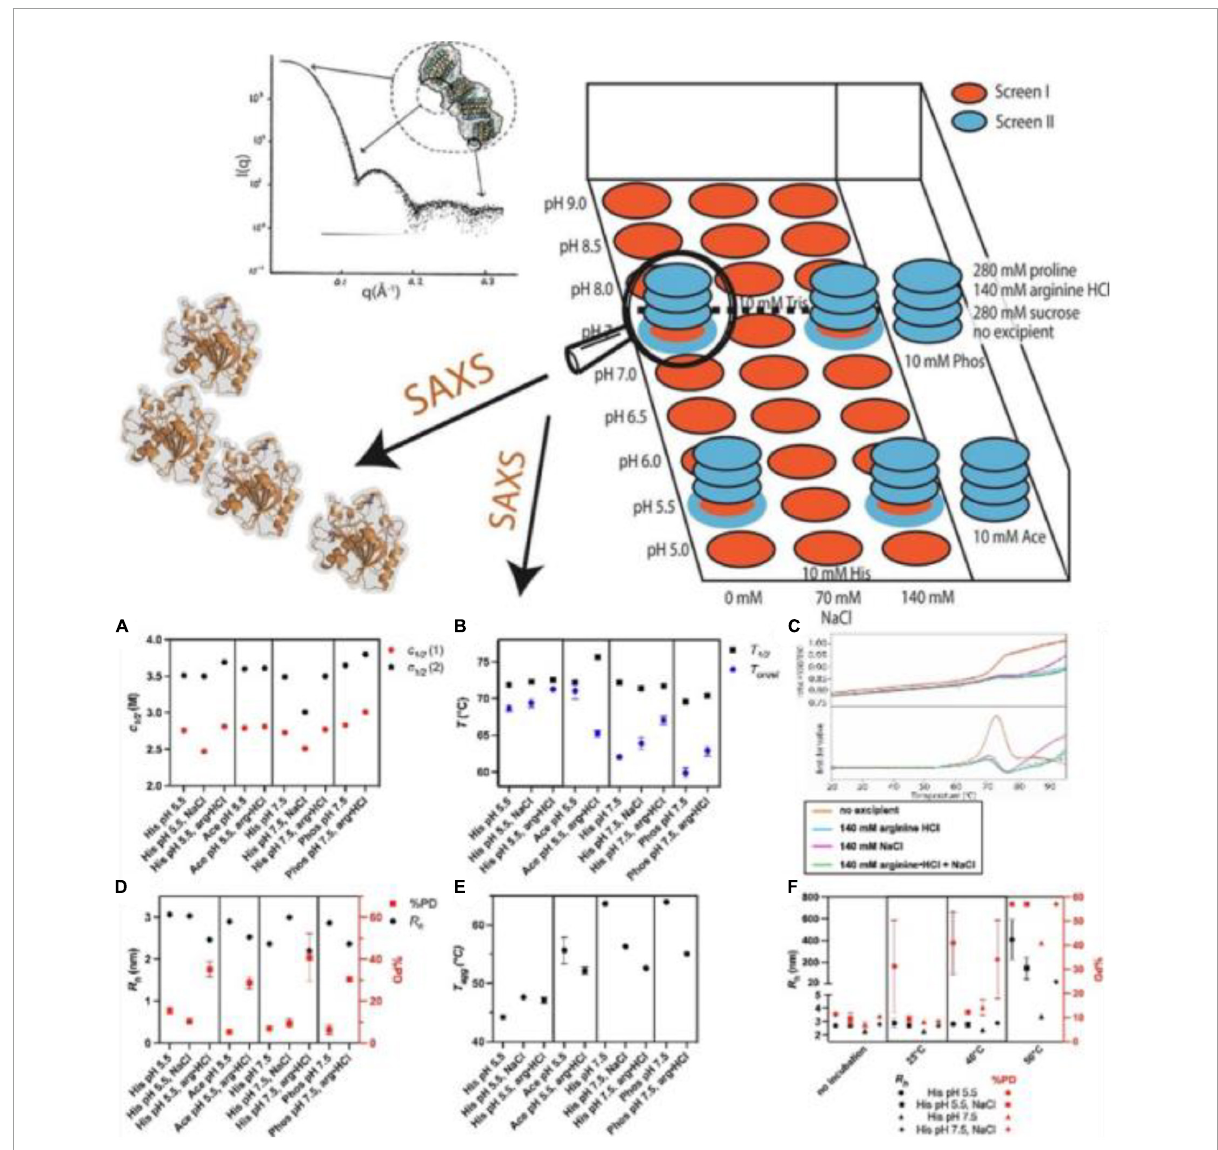
FIGURE4 (Top) Combination of high throughput and structural screening to assess protein stability using small-angle X-ray scattering (SAXS). (Bottom) (A–F) High throughput stability screening of Thermomyces lanuginosus (TLL) (91) (Copyright 2022 Elsevier